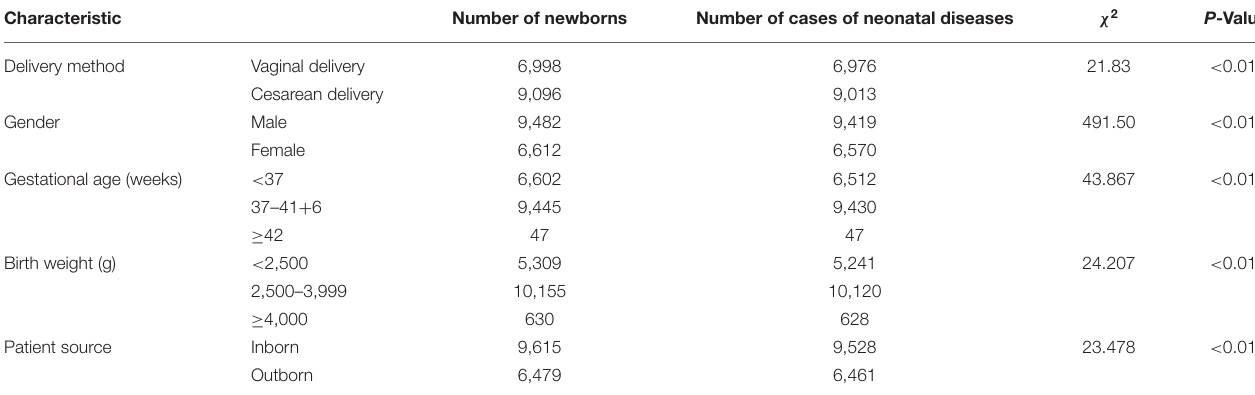
TABLE 6 | Prevalence of neonatal diseases in relation to different characteristics of the